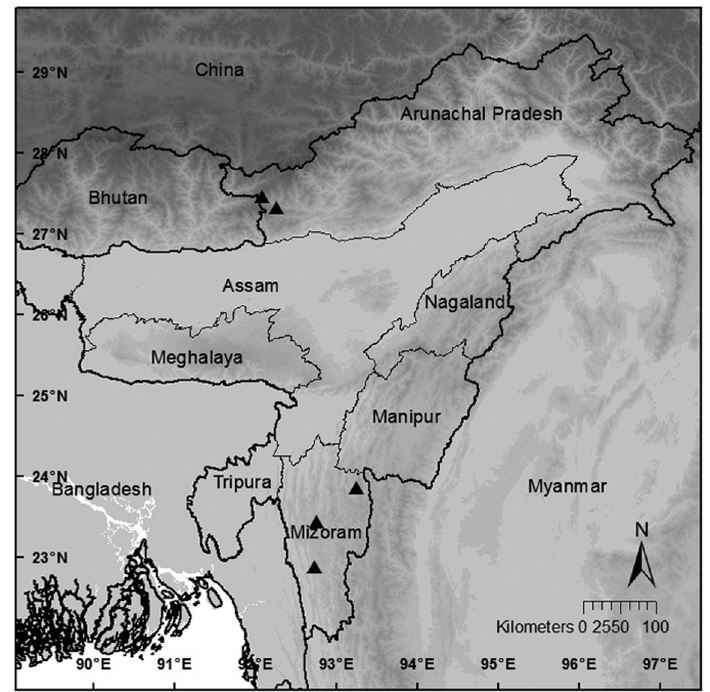
Fig. 22. Map showing the location of B. dioica Buch.-Ham. ex D.Don